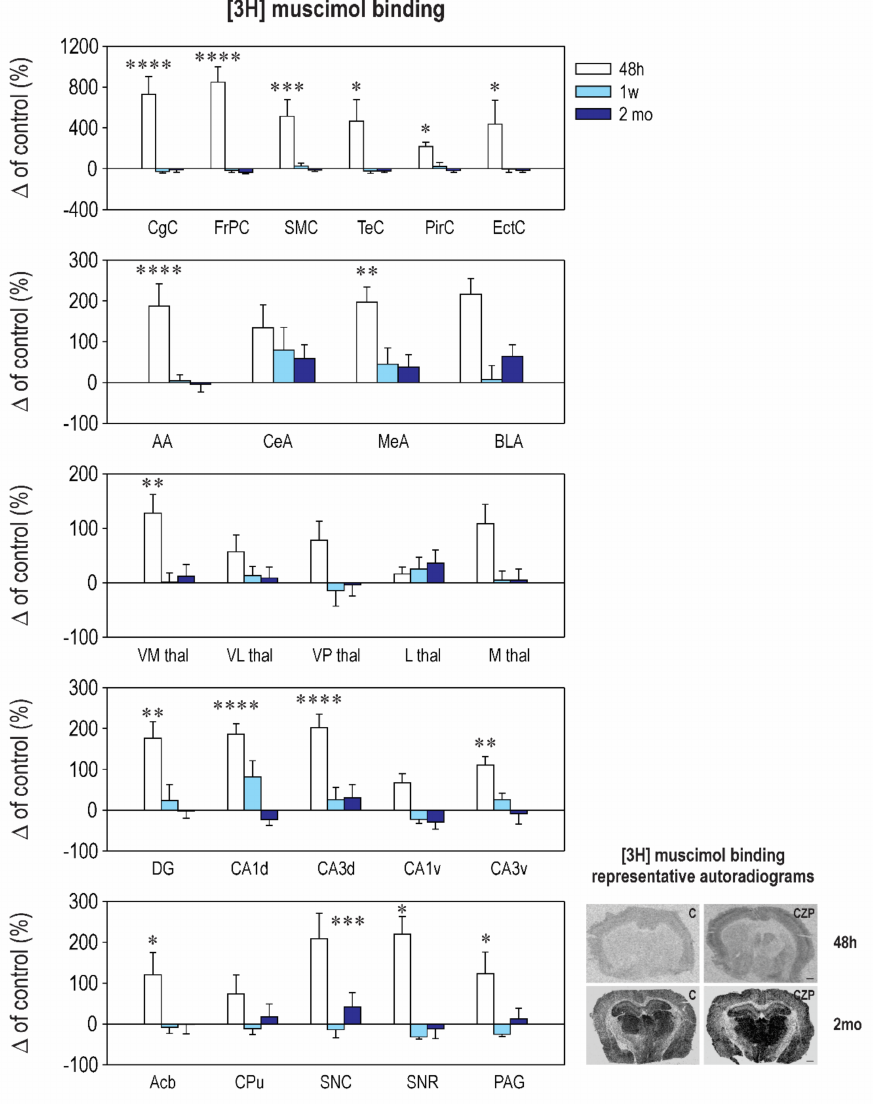
Figure 2. Relative changes in [3H] muscimol binding to GABA A receptors (means ± SEM): The binding in the control animals is considered as the baseline (zero) level. From the top to the bottom: cortical structures, amygdalar structures, thalamic structures, and hippocampal structures. On the bottom: Ncl. accumbens (Acb), caudate putamen (CPu), substantia nigra pars compacta (SNC), substantia nigra pars reticulate (SNR), and periaqueductal gray (PAG). [3H] Muscimol binding was assessed at three di ff erent intervals (48 h, 1 week, and 2 months—legend at the top) after CZP cessation. Abbreviations: CgC, cingulate cortex; FrPc, frontoparietal cortex; SMC, sensorimotor cortex; TeC, temporal cortex; PirC, piriform cortex; EctC, entorhinal cortex; AA, anterior amygdala; CeA, central amygdala; MeA, medial amygdala; BLA, basolateral amygdala; VN thal, ventromedial thalamus; VL thal, ventrolateral thalamus; VP thal, ventroposterior thalamus; L thal, lateral thalamus; M thal, medial thalamus; DG-, dentate gyrus of the hippocampus; CA1, CA1 subfield of the hippocampus; CA3, CA3 subfield of the hippocampus; d, dorsal; v, ventral. Each experimental group consisted of 5 animals. Asterisks denote significant di ff erences from the controls ( * p < 0.05; ** p < 0.01; *** p < 0.001; **** p < 0.0001 ). Scale bar = 1 mm. For other details, see Figure